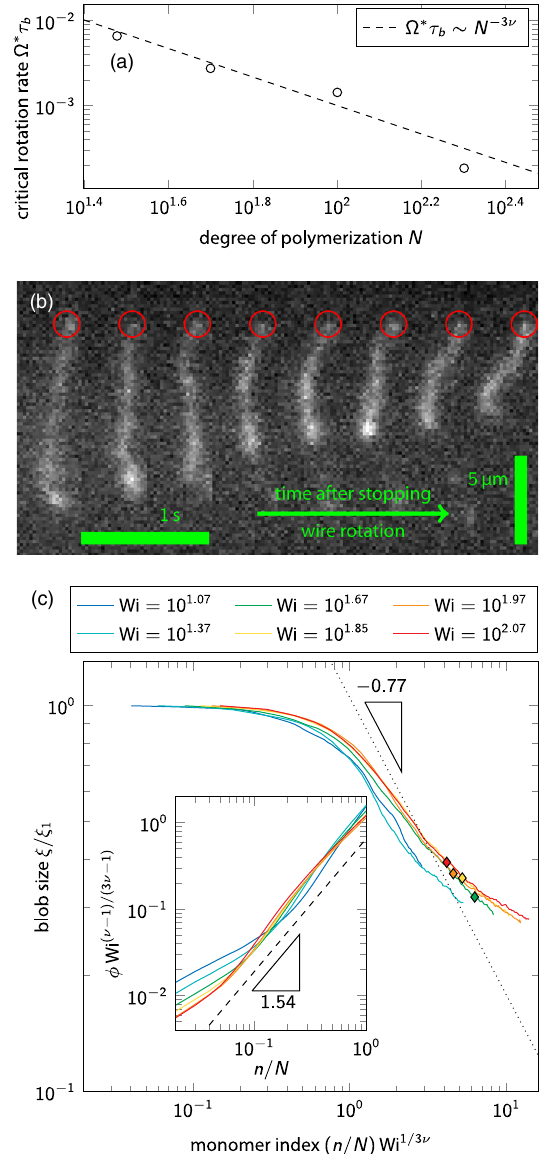
FIG. 5. Spooling tethered DNA strands. (a) Simulations of the critical rotation rate for which deformation of tethered DNA ∼ N − 3 ν . occurs. The solid line shows the predicted scaling of Ω (cid:2) Wi (b) Conformation of a single λ -phage DNA strand in the period immediately after the microwire has stopped rotating at Ω ¼ 130 rpm, showing the relaxation of the polymer (see Movie 2 in Ref. [16]). The end of the polymer that appears towards the top of the image is tethered to the wire. The conformational size is observed to increase steadily away from the tethering point, as predicted for a tethered polymer in the shofar configuration. (c) French-horn conformations seen via DPD blob size ξ as a function of segment index from the free end. Various rotation rates are collapsed according to Eq. (8), with blob size normalized by the free-end blob size ξ 1 . The dotted line shows the scaling prediction ξ ∼ n − ν = ð 3 ν − 1 Þ ∼ n − 0 . 77 . Diamonds ( ⋄ ) denote the Ω Þ − 1 . Inset: predicted transition from shofar to stem at n (cid:2) ≃ ð τ b Wrapping angle from the free end, collapsed via Eq. (7). The dashed line shows the scaling ϕ ∼ n 2 ν = ð 3 ν − 1 Þ ∼ n 1 . 54